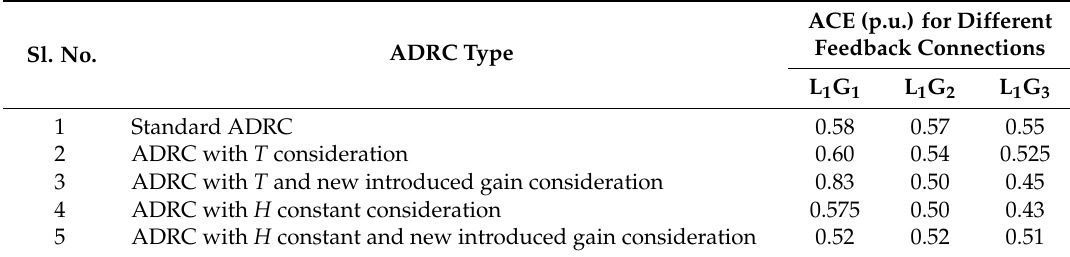
Table 3. Load change of 0.1 p.u. is applied separately from L 1 , L 2 and L 3 . Comparison among standard ADRC, ADRC with T and ADRC with H constant for ADRC based LFC with different feedback connection.